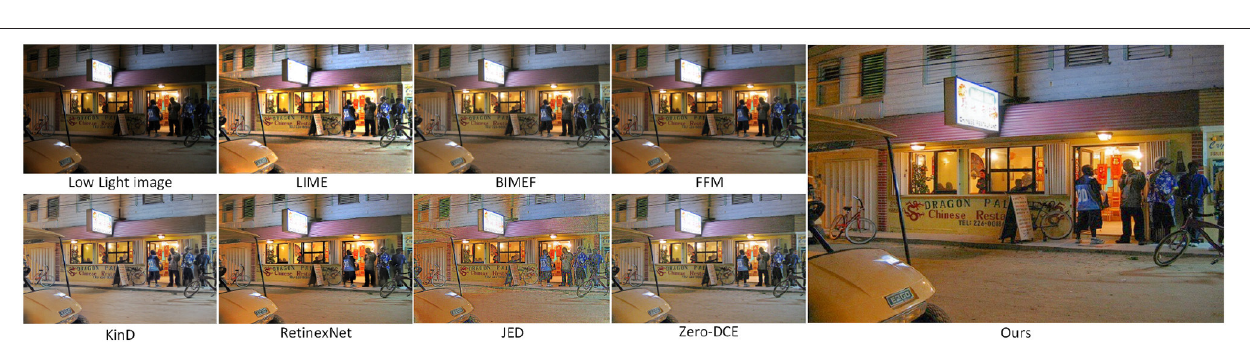
FIGURE 8 | Comparison of various low light image enhancement methods using night images from the DICM dataset.